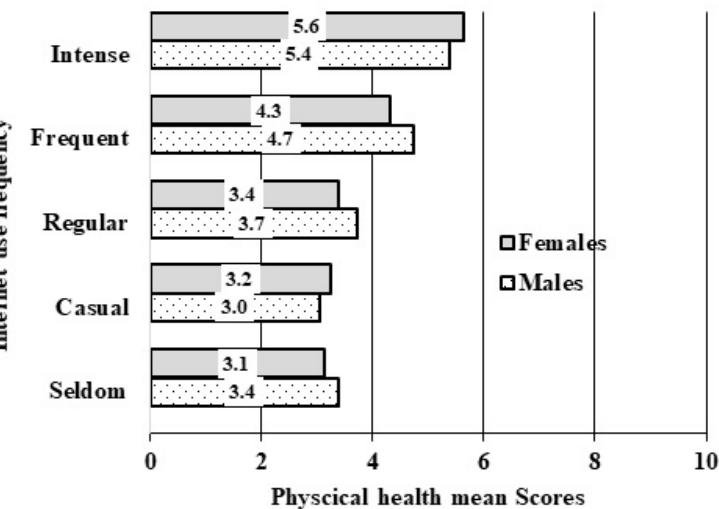
Figure 1. Mean scores of physical health under COVID-19 lockdown in Bangladesh, broken down by internet use and gender.